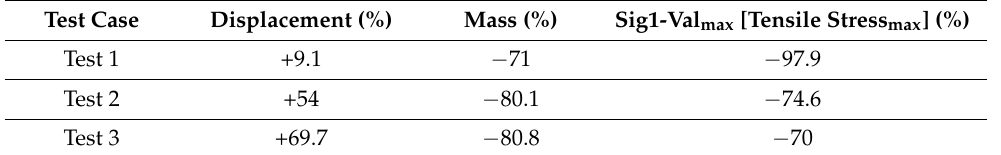
Table 3. Percentage variation